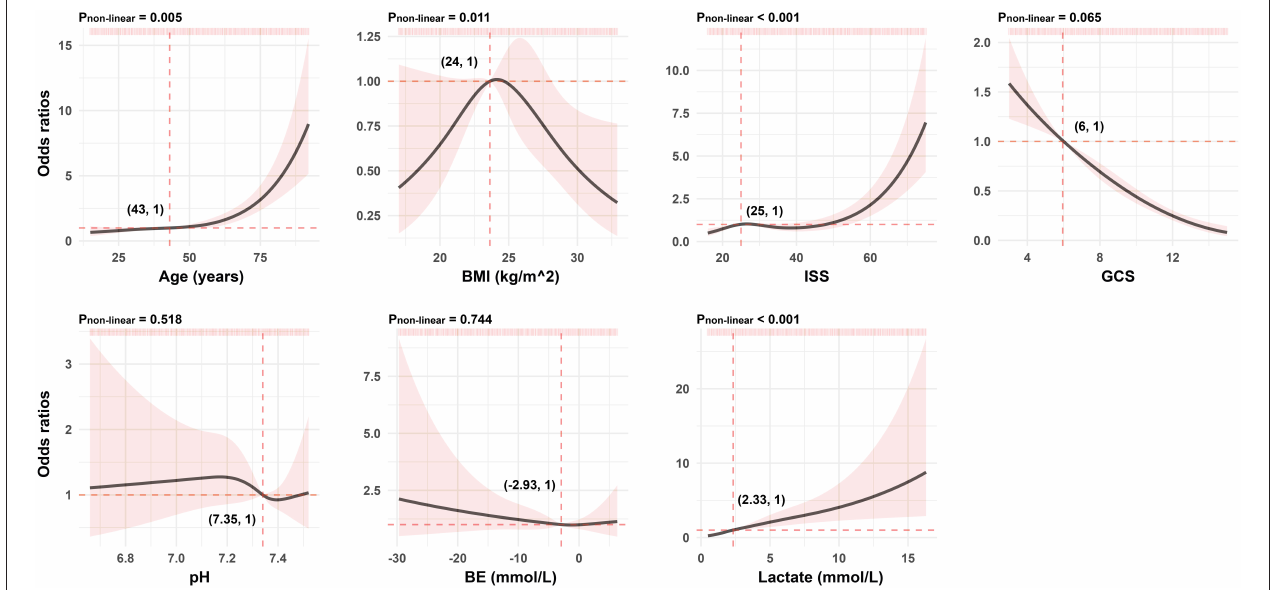
FIGURE 1 | Association between continuous predictors and 72-h mortality in patients with polytrauma by the RCS analysis. For each curve, five knots at the 5th, 35th, 50th, 65th, and 95th percentiles were selected. Solid lines represent odds ratios, and shaded areas represent 95% CIs. The reference point is the first value closest or equal to the odds ratio at 1 (i.e., the intersection of the two red dashed lines). RCS, restricted cubic spline; BMI, body mass index; ISS, injury severity score; GCS, Glasgow Coma Scale; BE, base excess.